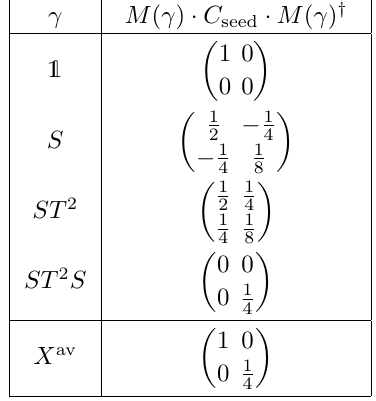
Table 2 . Orbit of the vacuum block for N = 2 ; k =